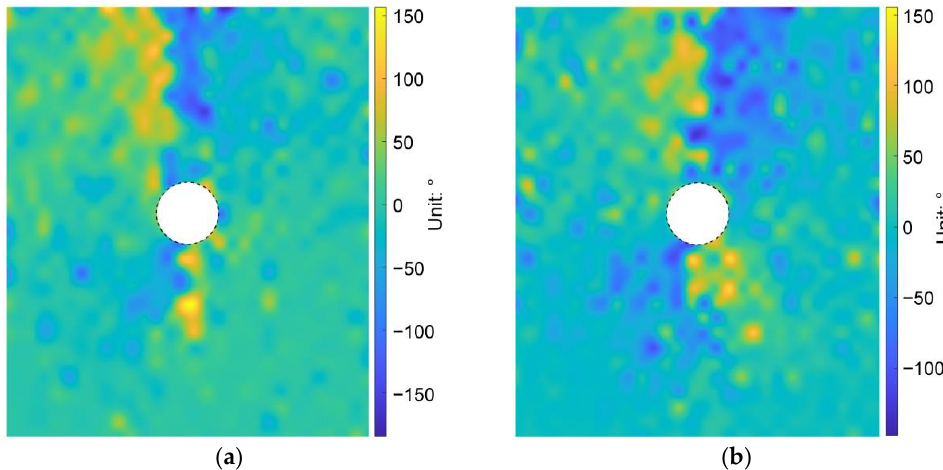
Figure 22. Stress variation angle after the tunnel excavation in the cases of ( a ) AR4C3 and ( b ) AR6C3.